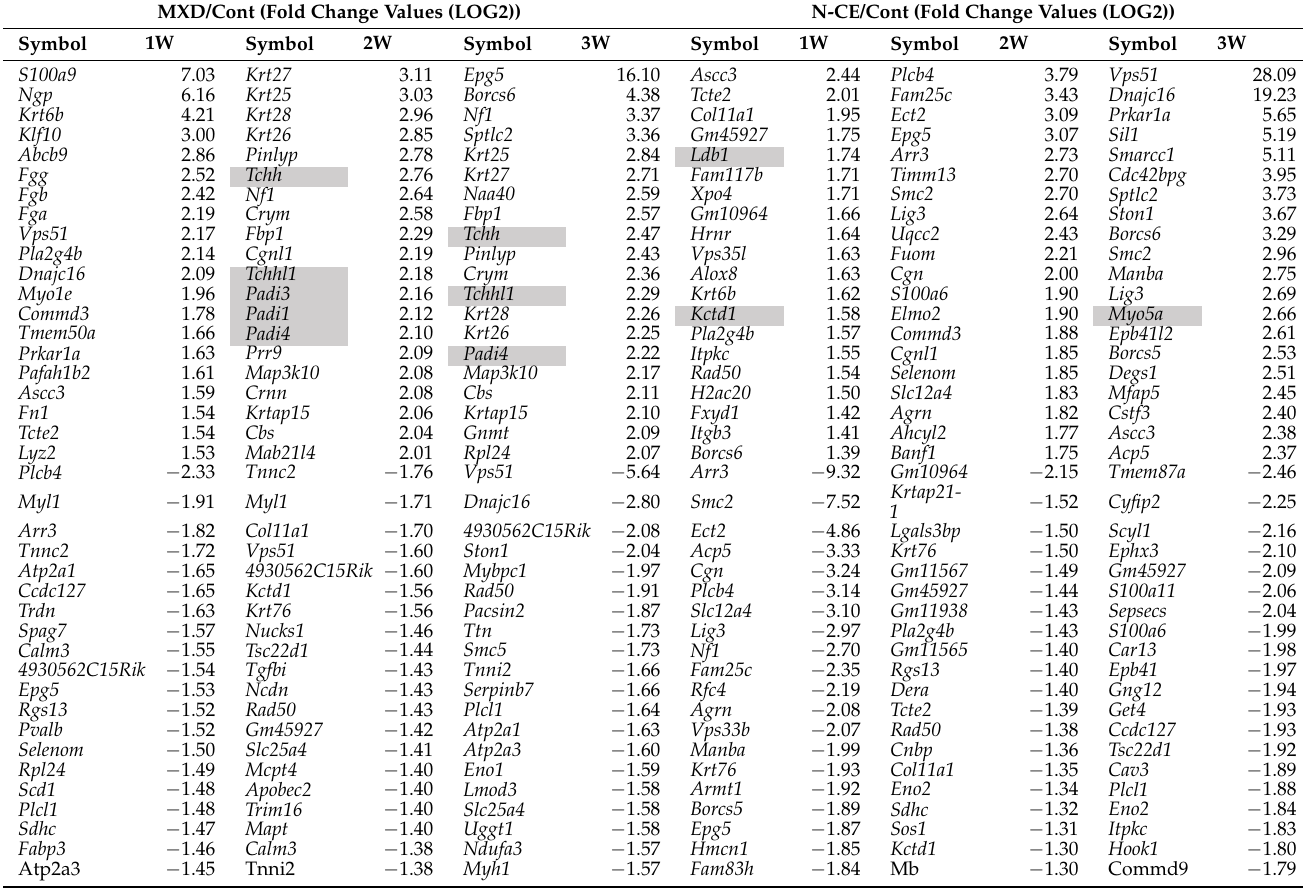
Table 4. A comparison of the up- and down-regulated genes in the MXD and N-CE group 1 week, 2 weeks, and 3 weeks after treatment. DNA microarray was performed as described in the Section